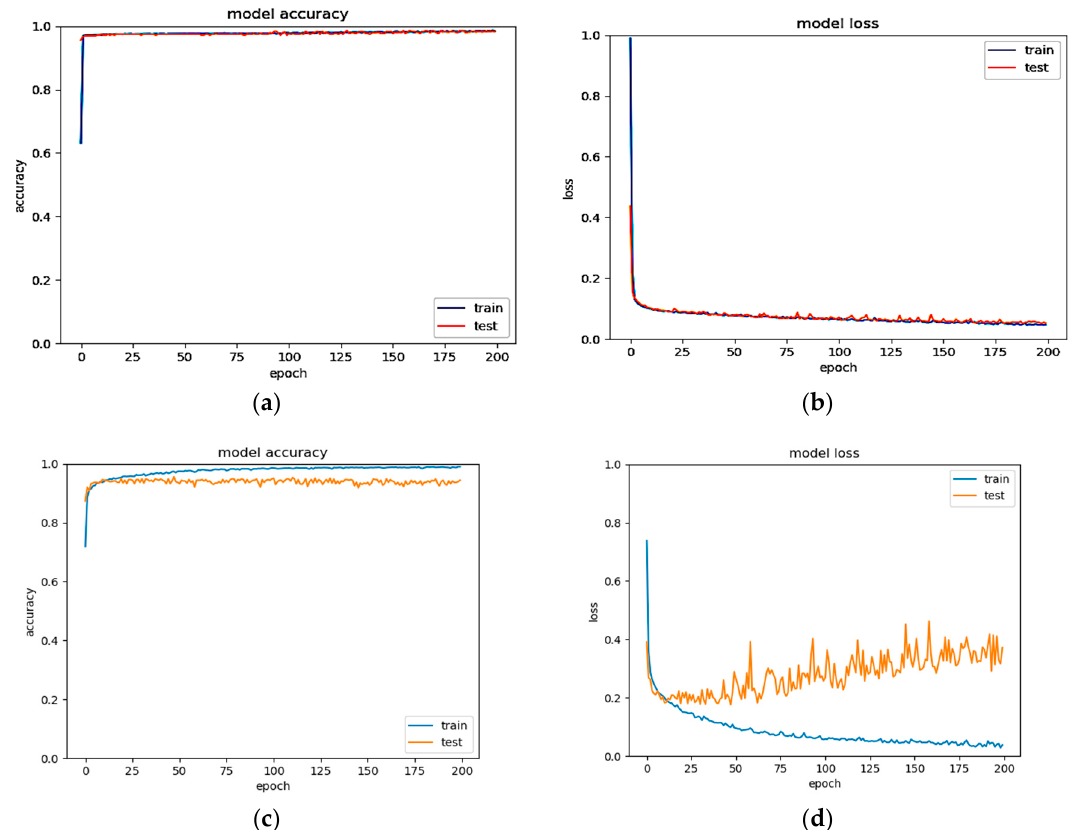
Figure 8. DL performance based on accuracy and loss curves. ( a ) Accuracy curve (DAEs–AEs–DNNs), ( b ) Loss curve (DAEs–AEs–DNNs), ( c ) Accuracy curve (DAEs–DNNs), ( d ) Loss curve (DAEs–DNNs). Table 8. The benchmark of the proposed model with another DL